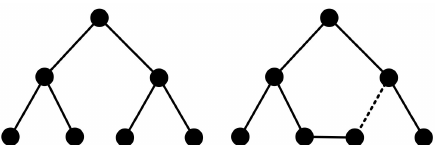
Figure 6. A simple example of distribution network reconfiguration (the dotted line represents the opening switch; the solid line represents the closed line).